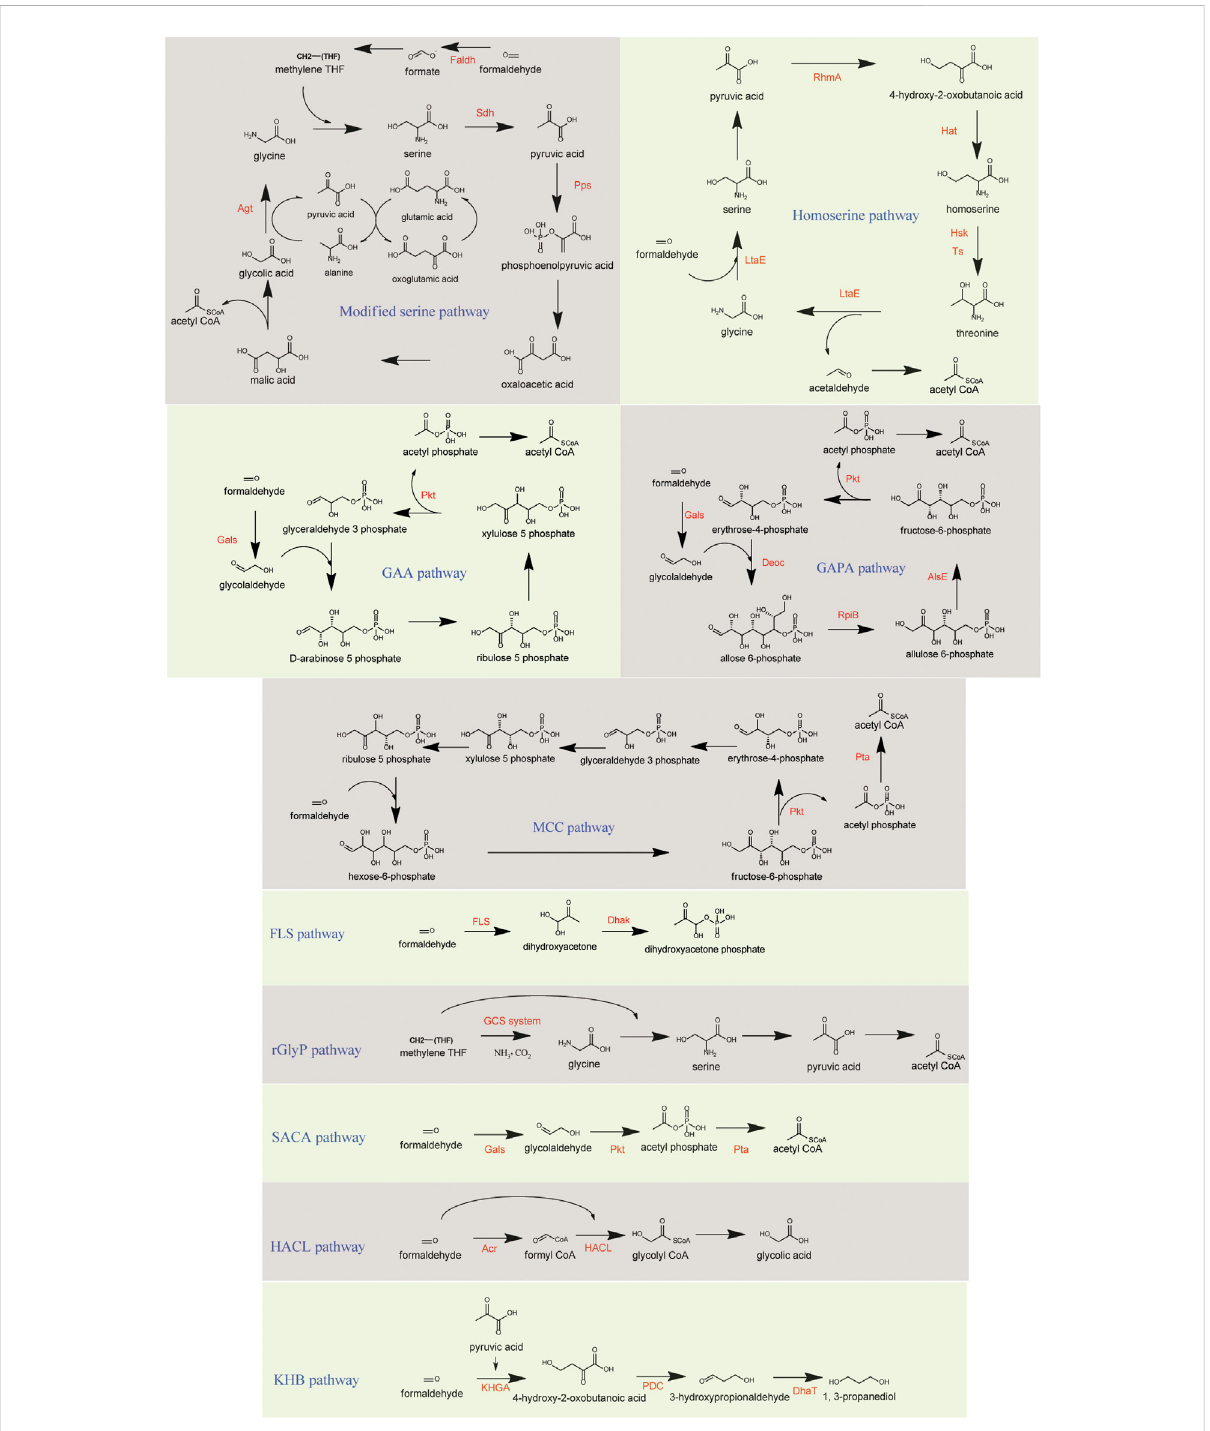
FIGURE 4 Methanolic carbon assimilation in synthetic pathways. Key enzymes are presented in red. GAA, glycoaldehyde assimilation pathway; GAPA, glycolaldehyde-allose6-phosphatepathway;MCC,methanolcondensationcycle;FLS,formolasepathway;rGlyP,reductiveglycinepathway;SACA, synthetic acetyl-CoA pathway; HACL, 2-Hydroxyacyl-CoA lyase pathway; KHB, ketohydroxy butyrate pathway. Faldh, formaldehyde dehydrogenase; Sdh, serine dehydratase; Pps, phosphoenolpyruvate synthase; Agt, alanine-glyoxylate transaminase; LtaE, threonine aldolase; RhmA,2-keto-3-deoxy-L-rhamnonatealdolase;Hat,HOBaminotransferase;Hsk,homoserinekinase;Ts,threoninesynthase;Gals,benzoylformate decarboxylase; Pkt, phosphoketolase; DeoC, 2-deoxy-D-ribose-5-phosphate aldolase; RpiB, ribose-5-phosphate isomerase B; AlsE, D-allulose-6- phosphate 3-epimerase; Pta, phosphate acetyltransferase; FLS, formolase; Dhak, dihydroxyacetone kinase; GCS system, Glycine cleavage